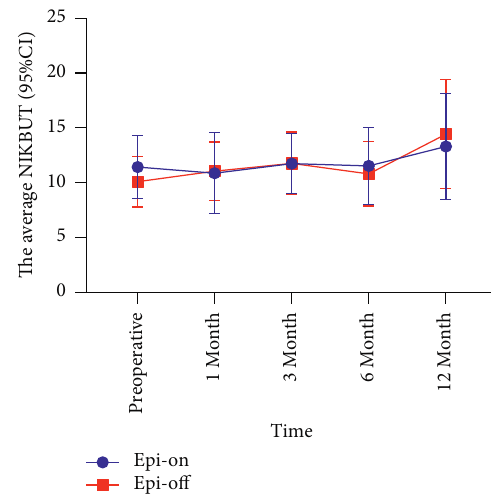
Figure 6: Comparison of the average NIKBUT during the 12- month follow-up period. NIKBUT: Noninvasive Keratograph breakup time; CI: confidence interval.